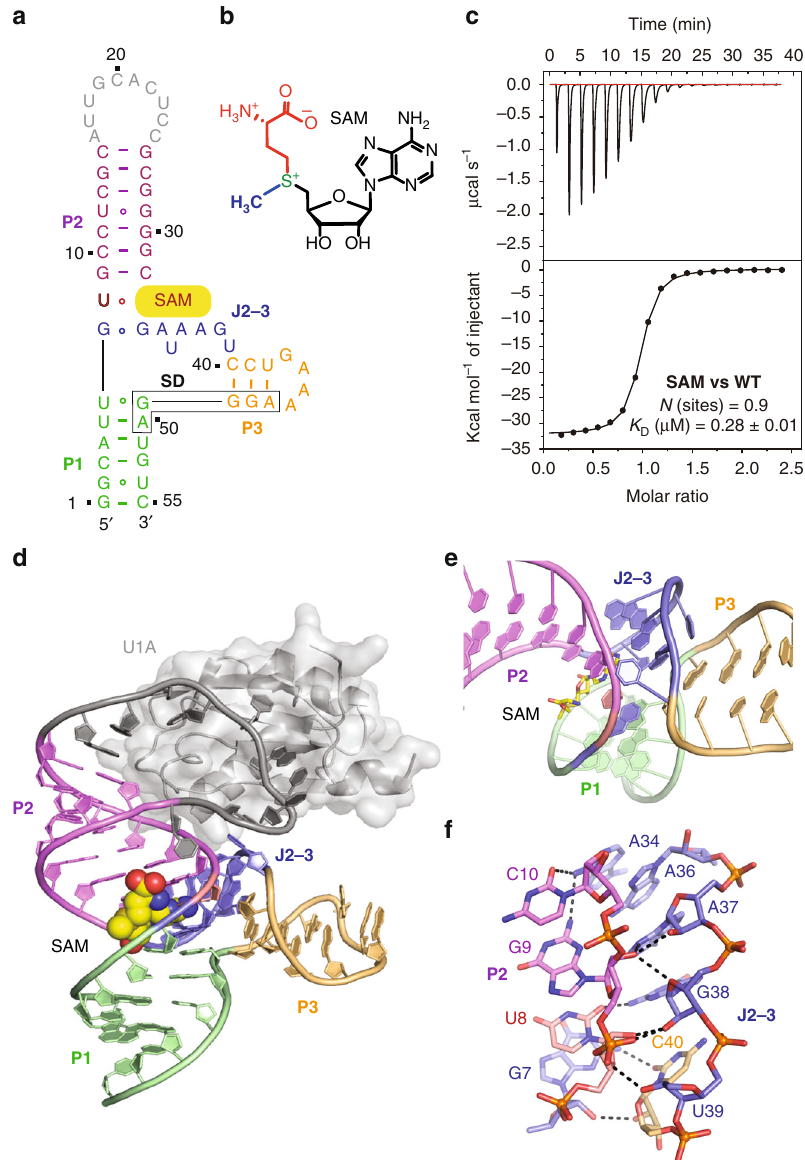
Fig. 1 Secondary and tertiary structure of the B. angulatum SAM-VI riboswitch. a Schematic of the folding topology based on the crystal structure of the SAM-VI riboswitch; the Shine-Dalgarno sequence is highlighted (box). b Chemical structure of SAM. c Exemplary ITC titration experiment of SAM-VI riboswitch binding with SAM; for arithmetic mean of K d value and thermodynamic parameters see Table 1 and Supplementary Table 2. d Cartoon representation of 2.7 A ̊ structure of the SAM-VI riboswitch, color-coded as in a . e Expanded view on the SAM-VI junction harboring the binding pocket. Stems P1 and P2 are co-axially stacked under the assistance of SAM adenine and junctional nucleotides involved in base pairing at the P1-P2 interface. P3 is located perpendicular to the P1-P2 axis and not directly involved in pocket formation. f Ribose and backbone interactions between stem P2 and junction J2- 3 (of four consecutive nucleotides each) shape the